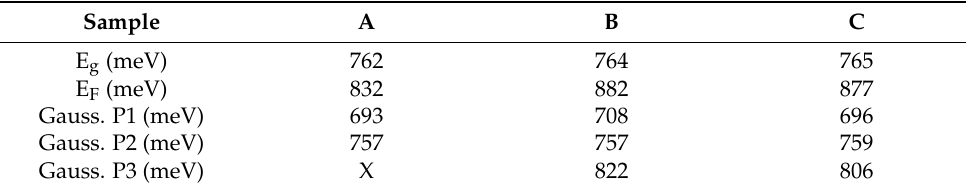
Table 2. Fitting results of the combination of Equation (1) and multiple Gaussian function. The energy values were all represented in meV.